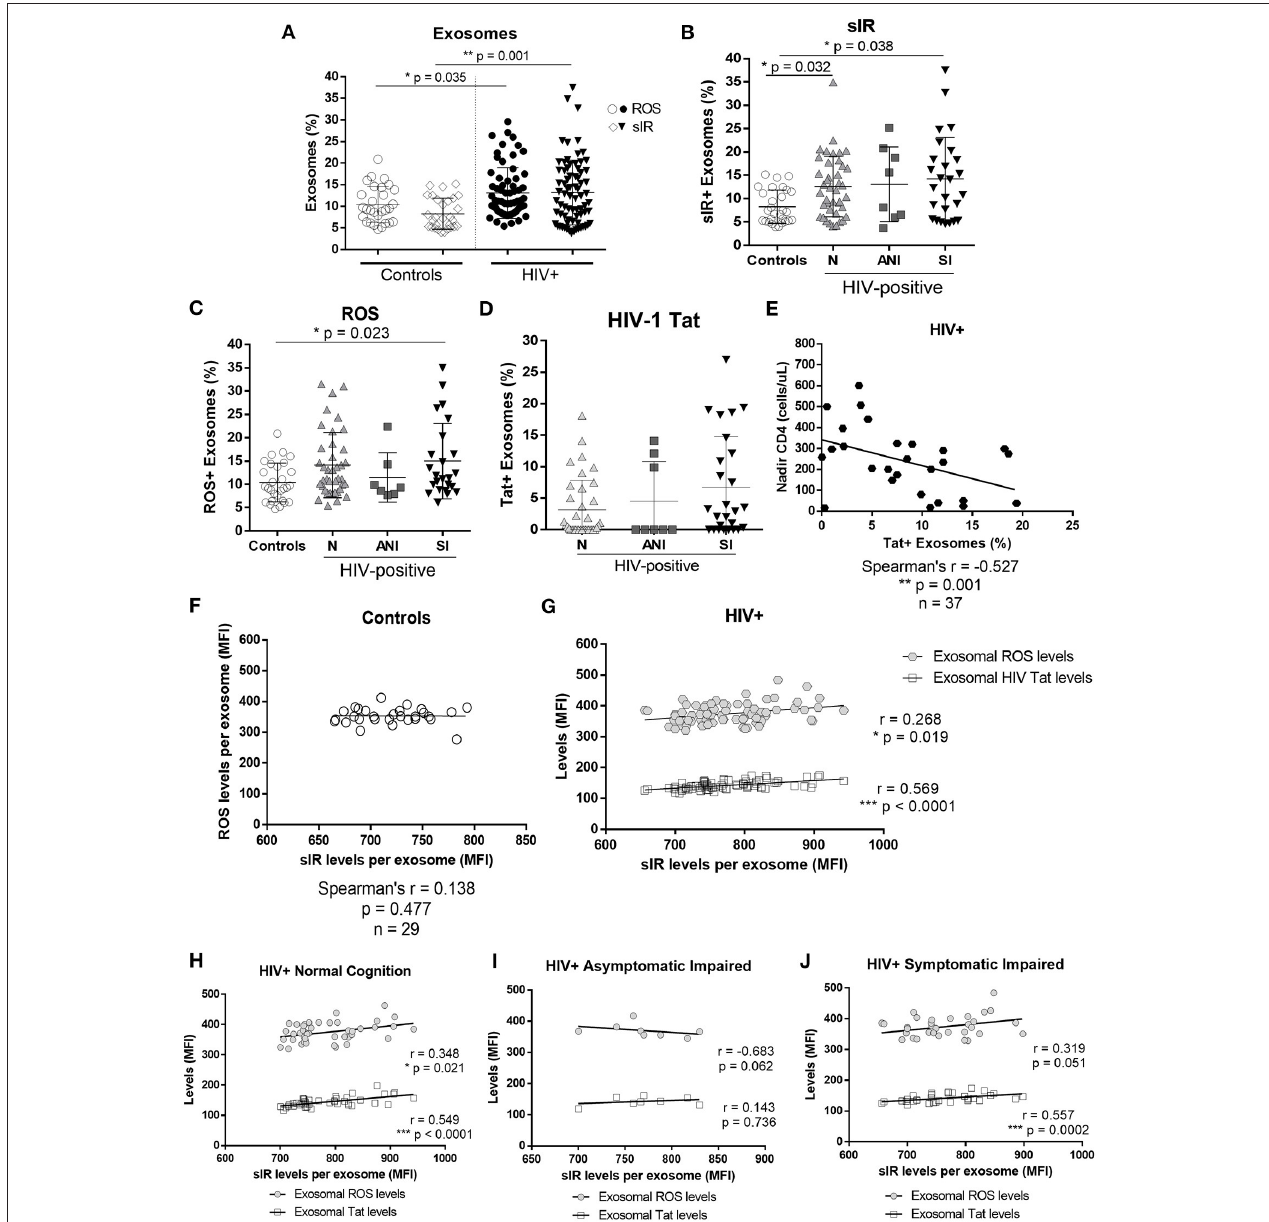
FIGURE 2 | Exosomal sIR, HIV-1 Tat, and ROS in control and HIV-infected women. Levels of sIR + , HIV-1 Tat + , and ROS + exosomes (exosome %) as well as the levels inside the exosomes were measured in exosomes isolated from the plasma of HIV-negative controls and HIV-infected women by flow cytometry (A) . HIV-infected women were stratified by HAND status as normal cognition (N), asymptomatic cognitive-impaired (ANI), and symptomatic impaired (SI; MND and HAD) (B–D) . Flow cytometry results were graphed as mean fluorescence intensity (MFI). Graphs show the mean and standard deviation. For percentage of sIR + exosomes (B) : [Controls (8.29 ± 3.58), N (12.59 ± 6.48), ANI (13.11 ± 8.01), and SI (14.25 ± 8.89)]; for ROS + exosomes (C) : [Controls (10.40 ± 4.18), N (14.15 ± 7.00), ANI (11.46 ± 5.31), and SI (15.01 ± 8.08)]; and for HIV-1 Tat + exosomes (D) : [N (3.16 ± 4.74), ANI (4.51 ± 6.33), and SI (6.75 ± 8.06)]. Kruskal–Wallis and Dunn’s multiple comparisons were used. Spearman’s correlation was also conducted between HIV-1 Tat + exosomes (%) and nadir CD4 + levels in HIV-infected women in samples where HIV-1 Tat + exosomes were detectable (E) . Spearman’s correlations between exosomal levels of sIR, ROS, and HIV-1Tat (HIV-infected samples only) were conducted in controls (F) and HIV-infected exosomes (G) . Stratified by cognitive performance, correlations of exosomal sIR with exosomal ROS and HIV-1 Tat were determined in HIV-infected women with normal cognition (H) , asymptomatic impairment (I) , and symptomatic impairment (J) using a Spearman’s correlation.